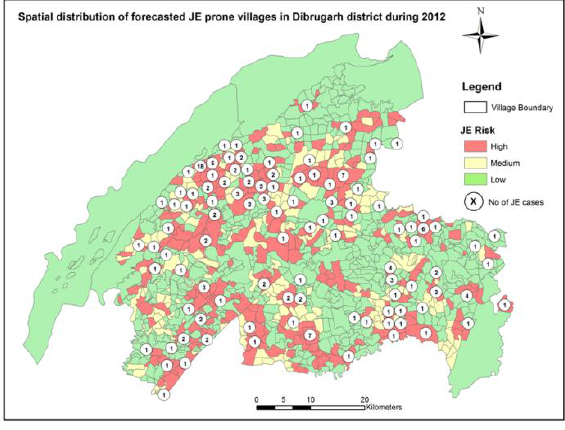
Figure 7. Spatial distribution of forecasted JE prone villages and actual occurrence of JE cases